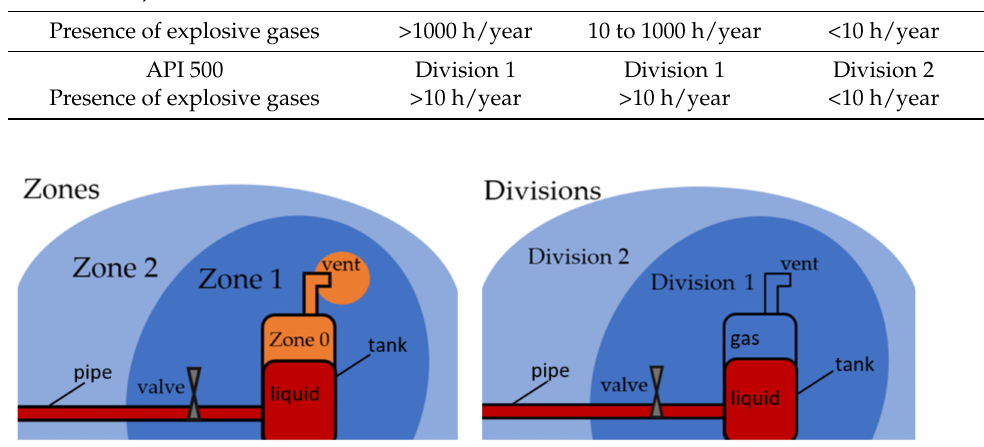
Figure 1. Zone and Division Systems: an illustrative example. Categories of equipment in the ATEX and IECEx schemes are equivalent are given in Table 6, where G refers to gaseous potentially explosive atmospheres. Table 6. Categories of equipment in the ATEX and IECEx schemes.